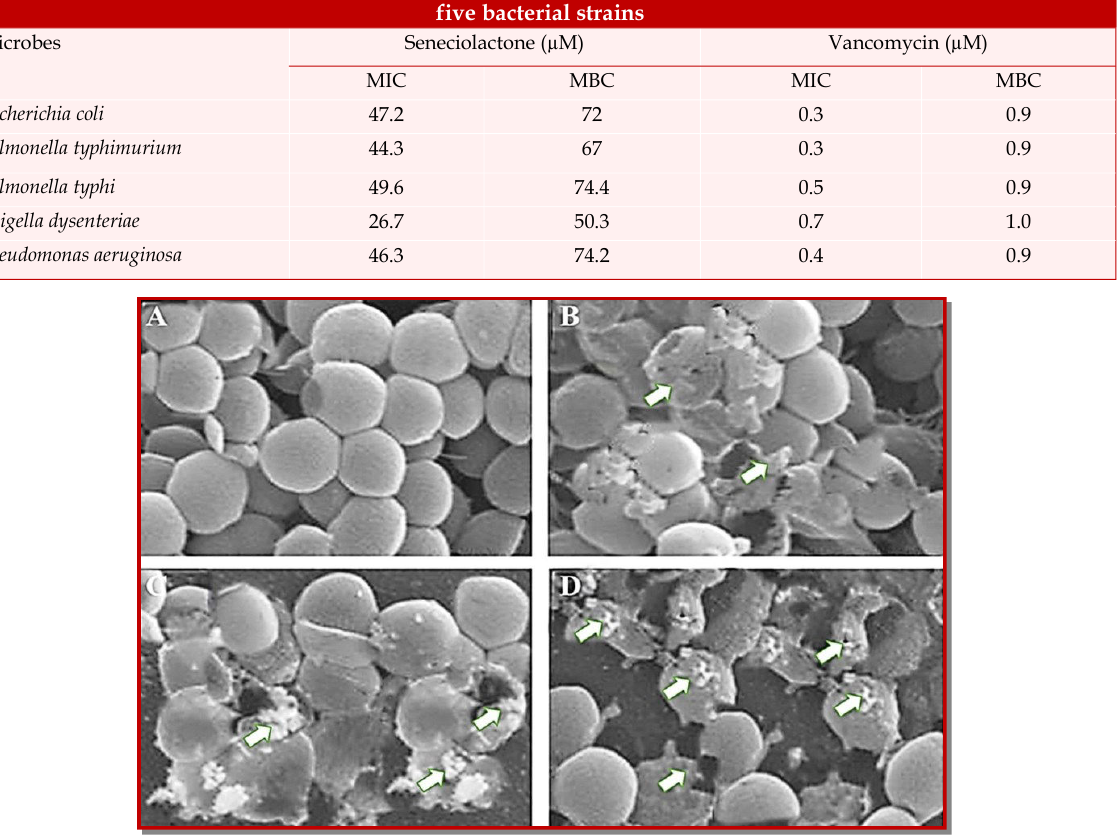
Figure 4: Effect of different doses of seneciolactone on the cell membrane integrity of Shigella dysenteriae using scanning electron microscopy. As compared to the untreated control (A), 10 µM (B), 25 µM (C) and 50 µM seneciolactone-treated bacterial cultures revealed significant damage to the cellular membrane (white